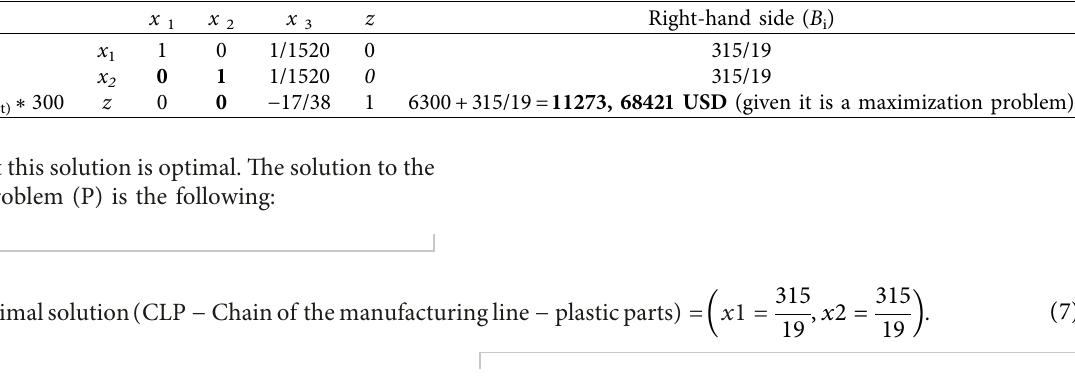
Table 6: Table of the optimal solution to problem